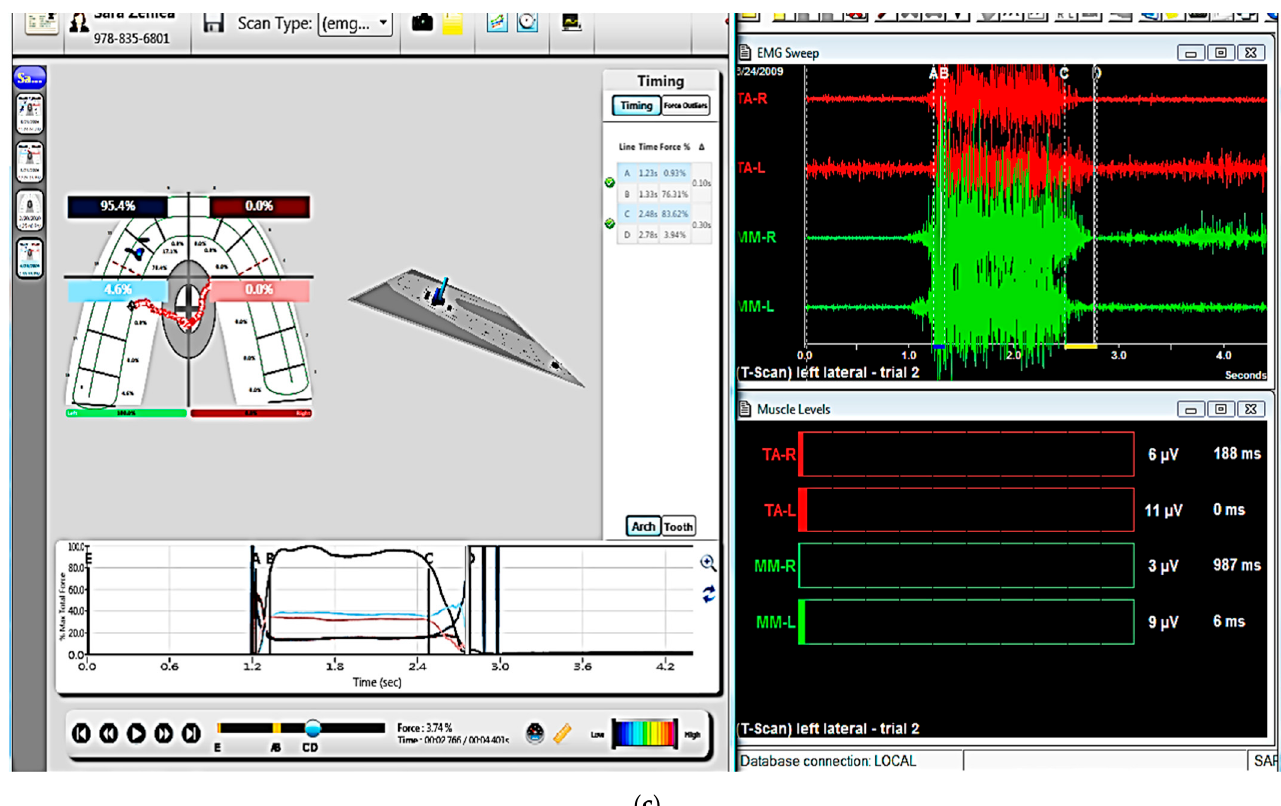
Figure 3. Electromyography (EMG) system (BioEMG system). ( a ) A device that collects the electrical signals and measures and amplifies the electric potential. The red socket is connected to the electrodes attached to the temporalis anterior muscle, the green one is connected to the electrodes attached to the masseter muscle, and the purple one and the blue one collect and measure the electric potential from the sternocleidomastoid and digastric muscles, respectively. ( b ) The electrodes with the sensors are attached with a patch to the skin near each muscle. ( c ) A computer screen provides the information of muscle activity. T-scan data (left) and EMG data (right) can be collected concurrently.